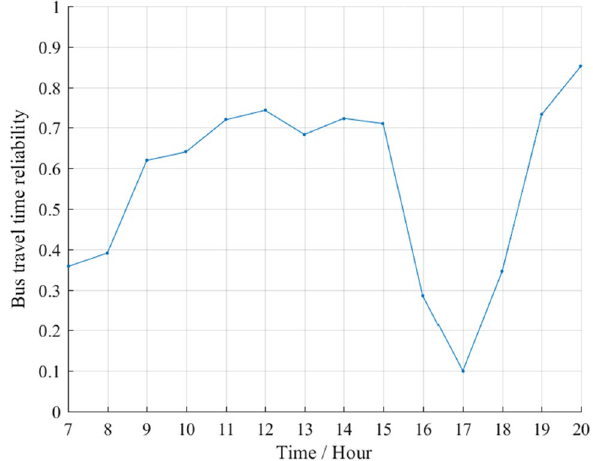
Fig. 2 The hourly bus travel time reliabilities in December 3, 2012 under different 𝛾